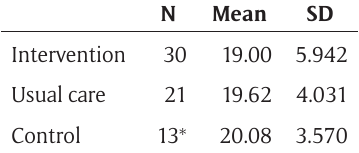
Table 3: Comparison of mean and standard deviation (SD) Nutritional Knowledge total scores between groups at baseline (T1) and non-parametric Kruskall-Wallis Test.